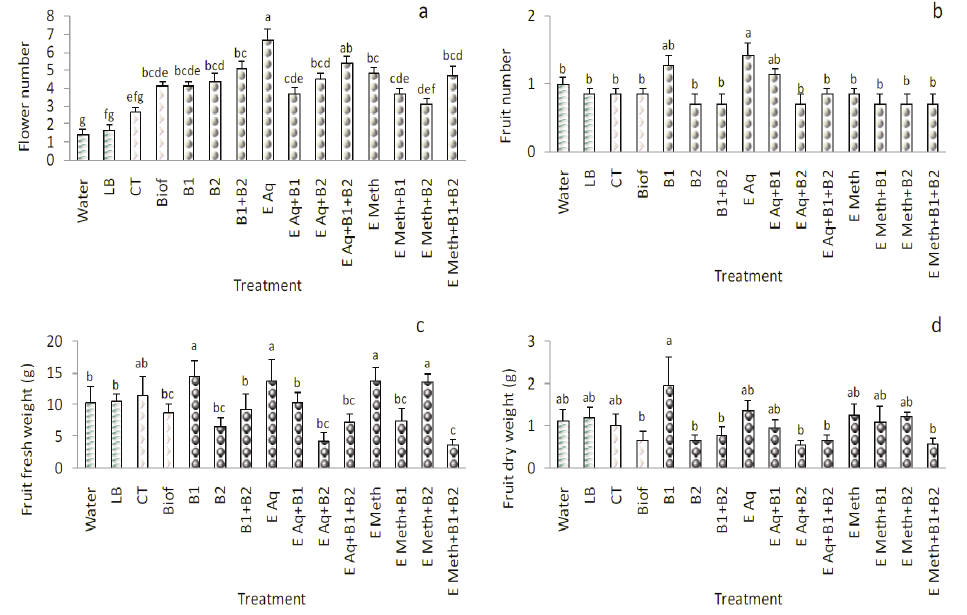
Fig. 3 ­ Comparative efficacy of single and combined bio­treatments with Sargassum vulgare extracts and selected Bacillus spp. strains on the eggplant flowers and fruit production compared to the untreated control and to two organic amendments. Water= Plants treated with water; LB= Plants treated with Luria­Bertani broth medium; CT= Plants treated with a compost tea; Biof= Plants treated with a commercial bio­fertilizer (Acadian™); B1= Single treatment with B. subtilis SV41; B2= Single treatment with B. amyloliquefaciens subsp. plantarum SV65; B1+B2= Combined treatment with B. subtilis SV41 and B. amyloliquefaciens subsp. plantarum SV65; E Aq= Single treatment with aqueous S. vulgare extract; E Aq+B1= Combined treatment with S. vulgare aqueous extract and B. subtilis SV41; E Aq+B2= Combined treatment with aqueous S. vulgare extract and B. amyloliquefaciens subsp. plan‐ tarum SV65; E Aq+B1+B2= Combined treatment with aqueous S. vulgare extract and both Bacillus spp. strains. E Meth= Single treatment with methanolic S. vulgare extract. E Meth+B1= Combined treatment with methanolic S. vulgare extract and B. subtilis SV41; E Meth+B2= Combined treatment with methanolic S. vulgare extract and B. amyloliquefaciens subsp. plantarum SV65; E Meth+B1+B2= Combined treatment with methanolic S. vulgare extract and both Bacillus spp. strains. Bars sharing the same let­ ters are not significantly different according to Multiple Range Duncan test at 5%. (a) Comparative efficacy of tested bio­treat­ ments on eggplant flower number; (b) Comparative efficacy of tested bio­treatments on eggplant fruit number; (c) Comparative efficacy of tested bio­treatments on eggplant fruit fresh weight; d: Comparative efficacy of tested bio­treatments on eggplant fruit dry